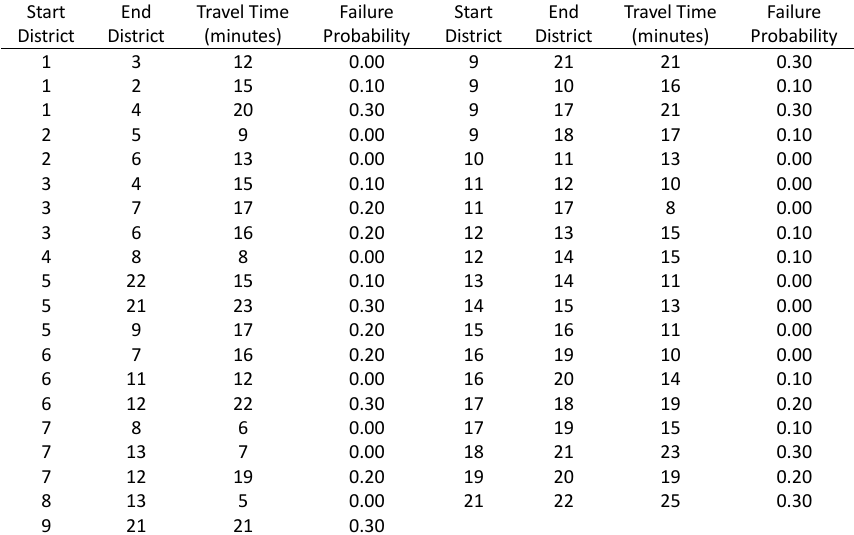
Table 2: Link information of Tehran (Edrissi, et al, 2015)